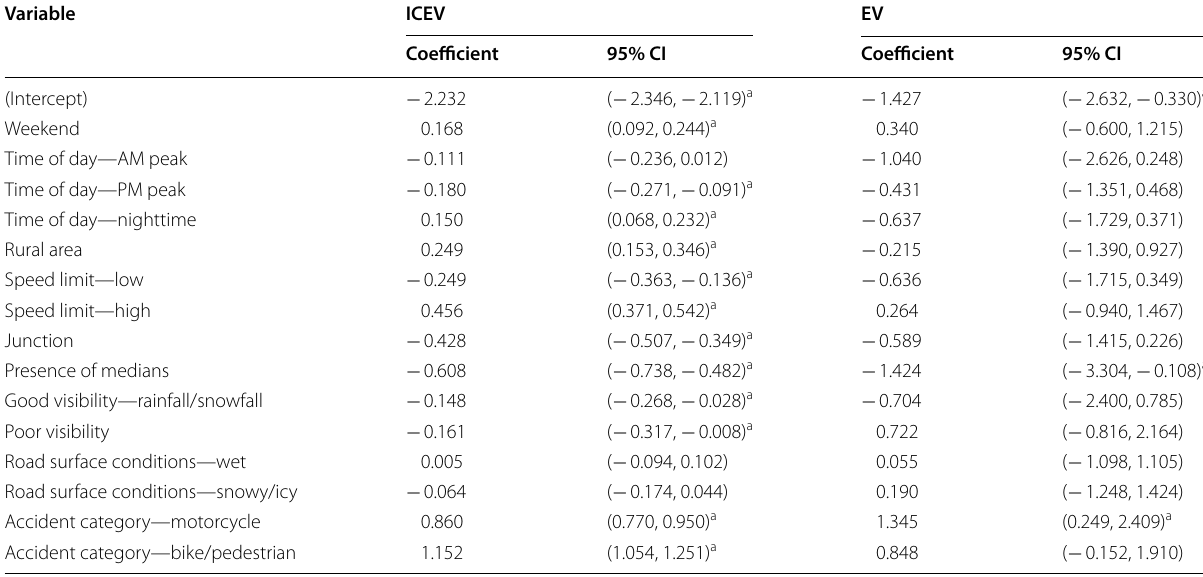
CI confidence interval a Indicates significance at alpha